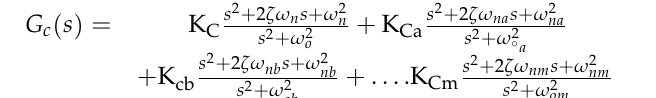
Figure 13. The voltage control response for the DC link.